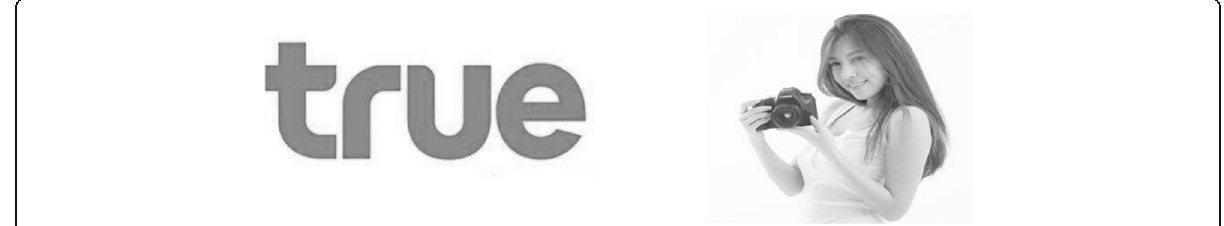
Fig. 4 Embedded carrier image and extracted hidden image